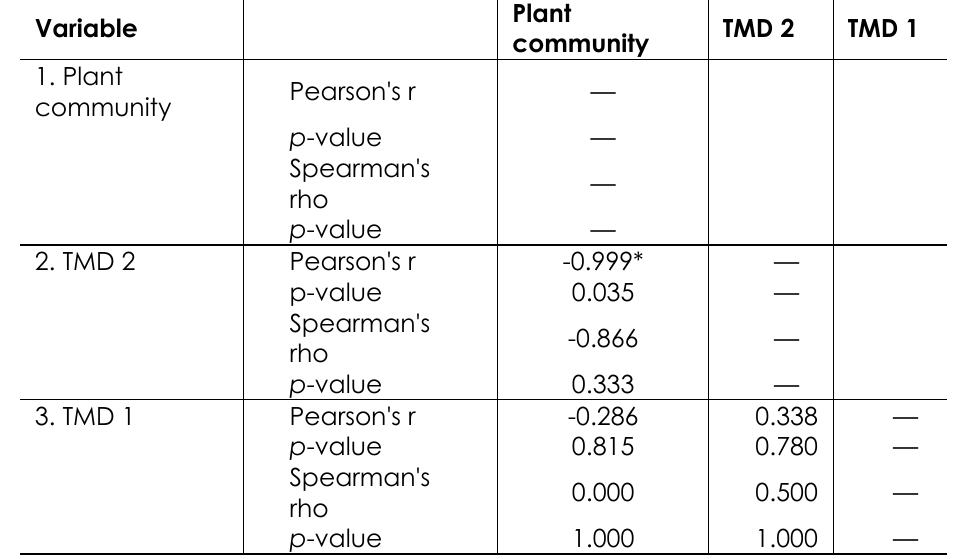
Table 4. Correlation Analysis of POMS and Landscape Elements.